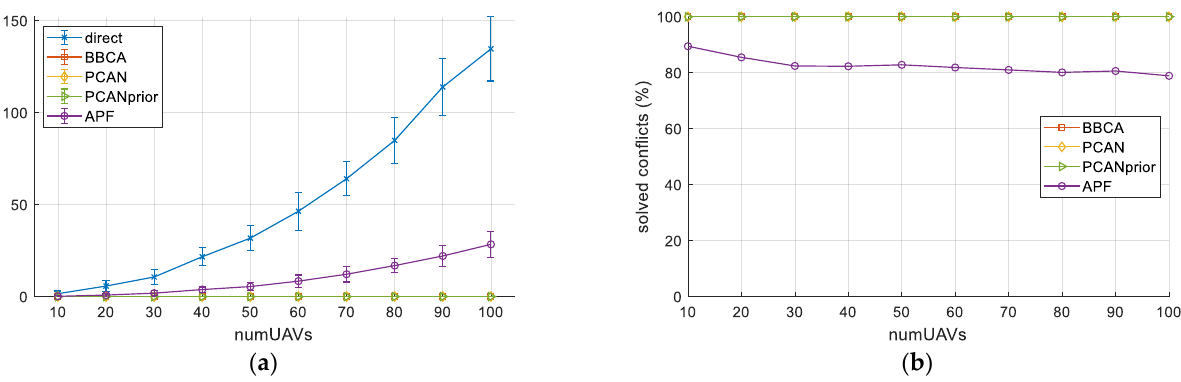
Figure 8. Number of conflicts: ( a ) not solved conflicts (mean and deviation); ( b ) solved conflicts (%).